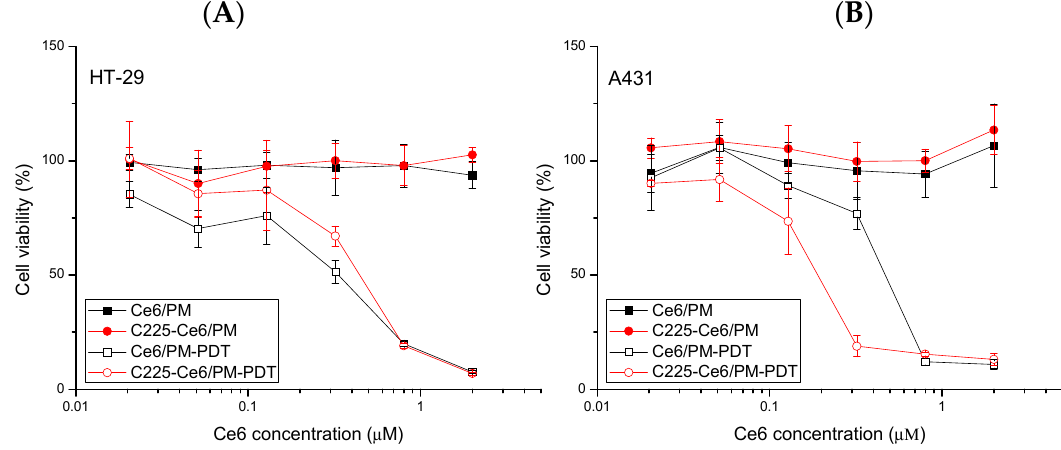
Figure 5. Cytotoxicity and phototoxicity of Ce6/PM and C225-Ce6/PM with or without light irradiation. The light dose was 10 J/cm 2 . ( A ) Low-EGFR-expressing HT-29 cells; ( B ) High-EGFR-expressing A431 cells.